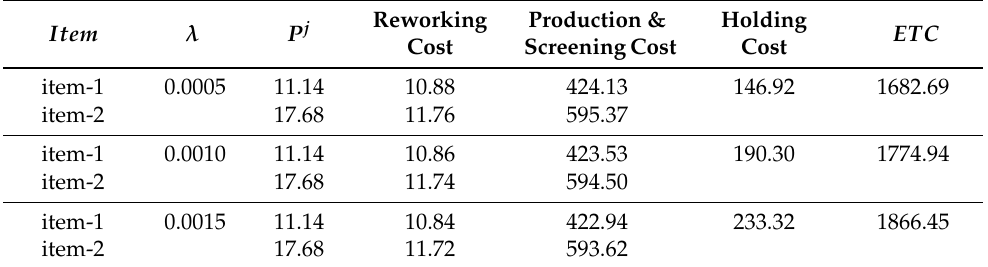
Table 8. Comparison results for dissimilar values of λ